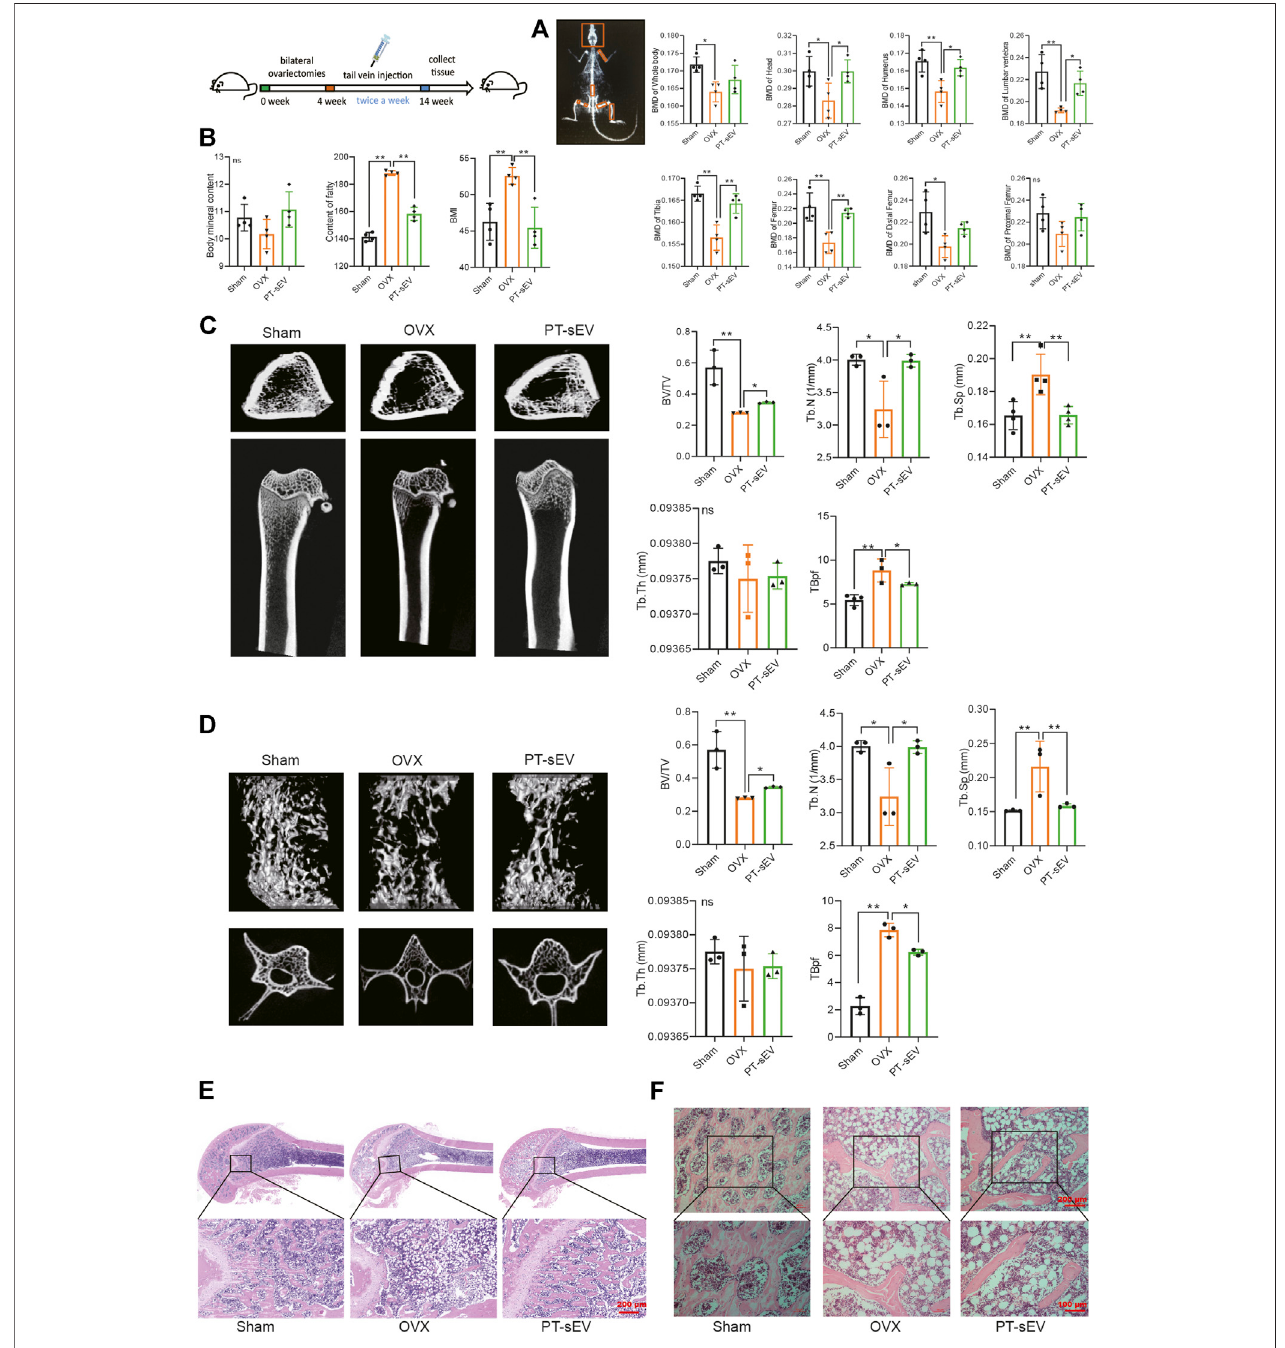
FIGURE 3 | PT-sEV moderated bone mass and bone microstructure in OVX rats. (A) The BMD at different positions in different groups ( n (cid:2) 4), the raw data represented the replicate value; (B) The BMI, the content of fatty and content of BMC in different groups ( n (cid:2) 4), the raw data represented the replicate value; (C) The micro-CTresultsoffemur( n (cid:2) 4),therawdatarepresentedthereplicatevalue; (D) Themicro-CTresultsoflumbarvertebrae( n (cid:2) 3),therawdatarepresentedthereplicate value; (E) HE staining of femur, scale bar: 200 μ m; (F) HE staining of lumbar vertebrae, scale bar: 200 μ m or 100 μ m * p < 0.05, ** p < 0.01, ns: non-signi fi cant, analyses were done twice and obtained comparable